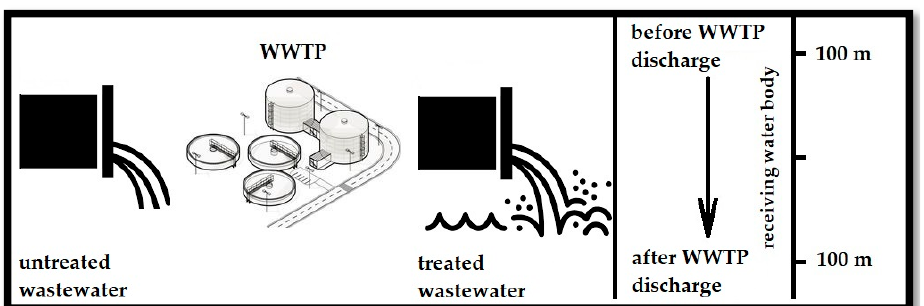
Figure 2. General representation of the sampling scheme at each sampling location.